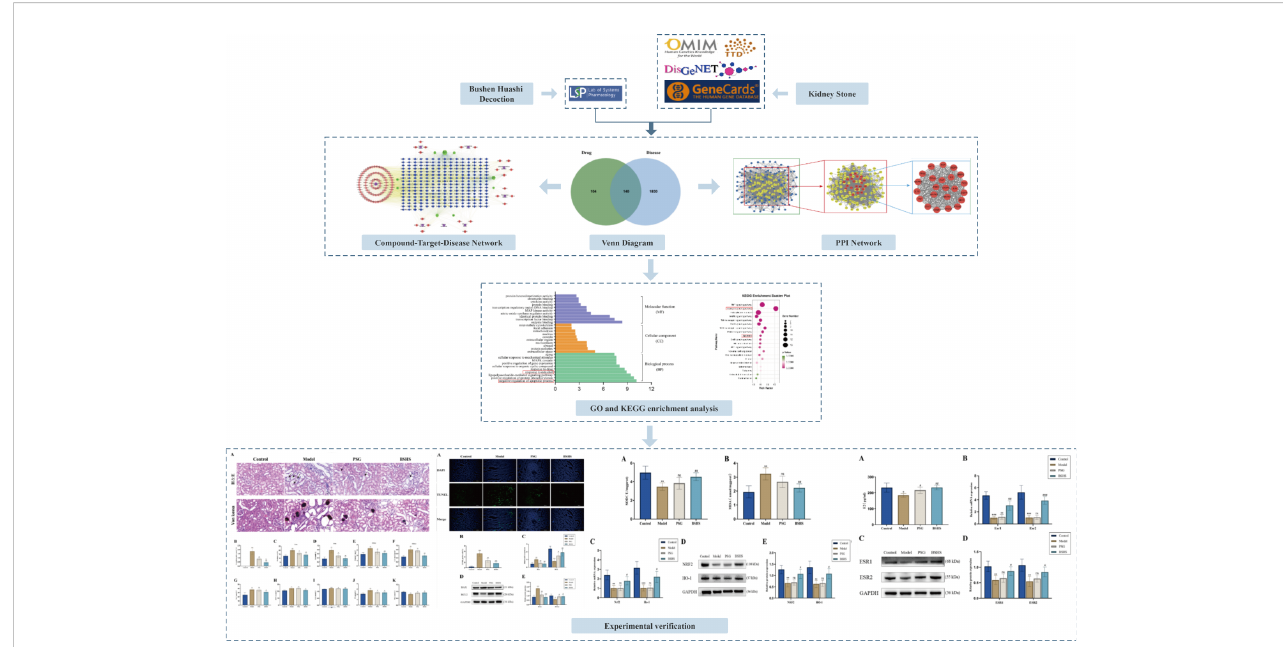
FIGURE 1 The fl owchart illustrates the mechanism of BSHS in KS, from target identi fi cation, network construction, and enrichment analysis to experimental